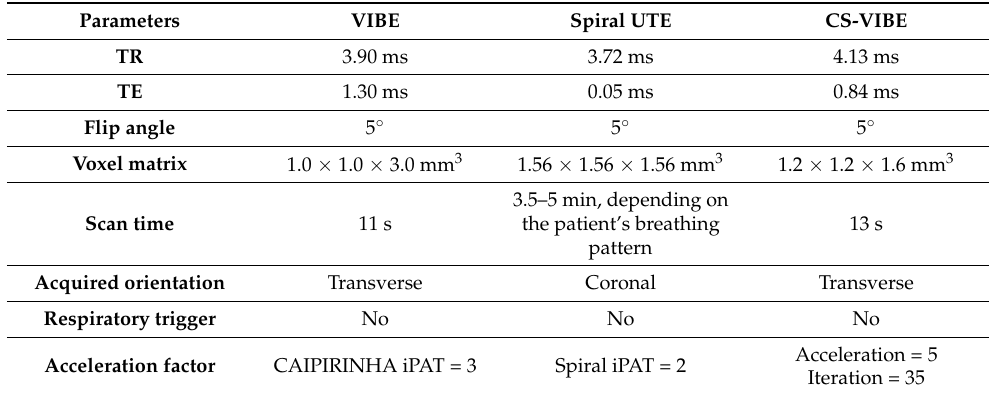
Table 1. Parameters of conventional VIBE, spiral UTE, and CS-VIBE sequences in lung MR images.